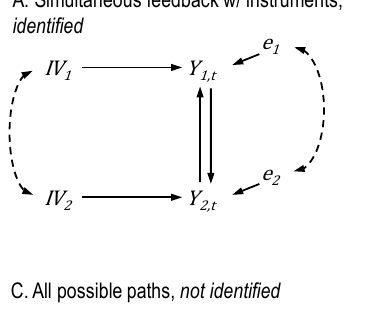
Figure 2. Various Models of Reciprocal Causality